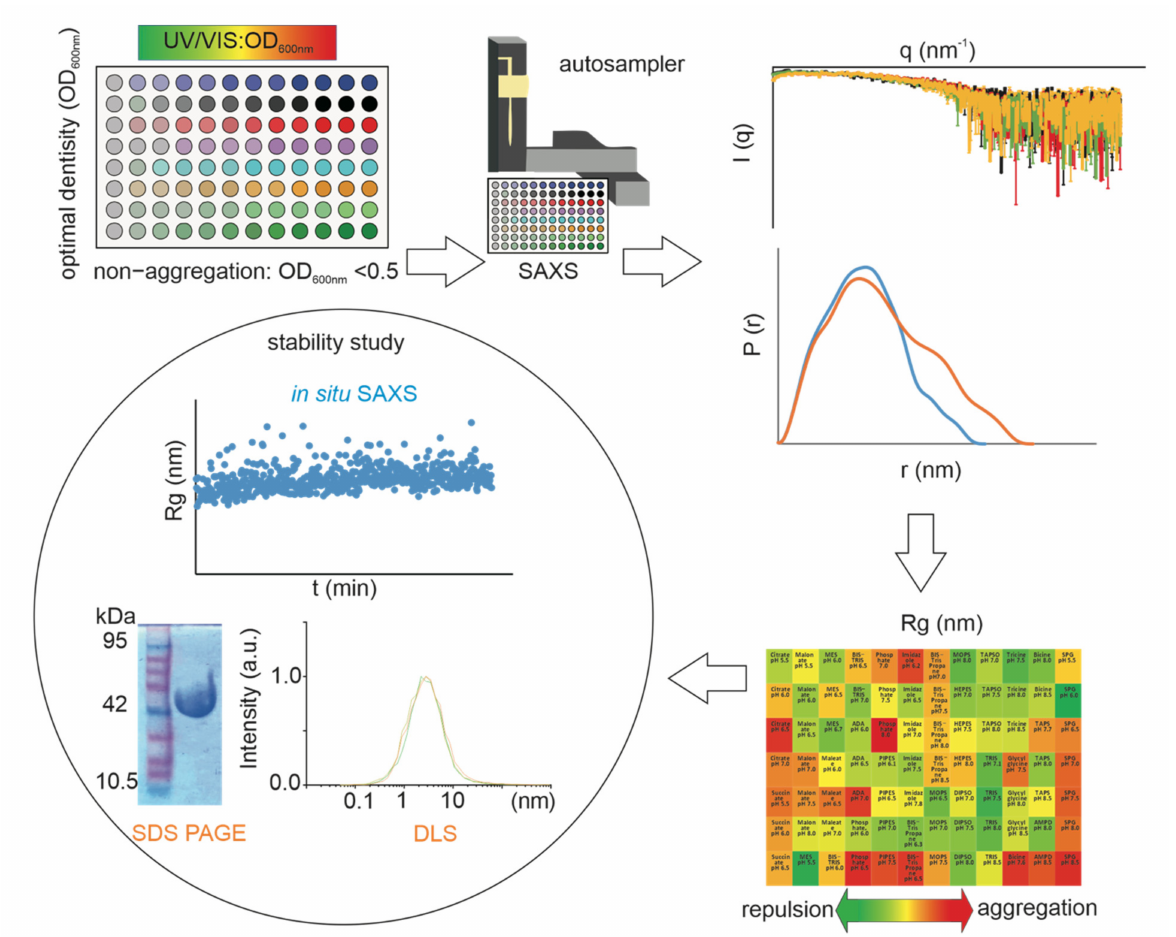
Figure 1. Illustration of the SAXS Screen workflow on a single screening for studying physical stability of protein